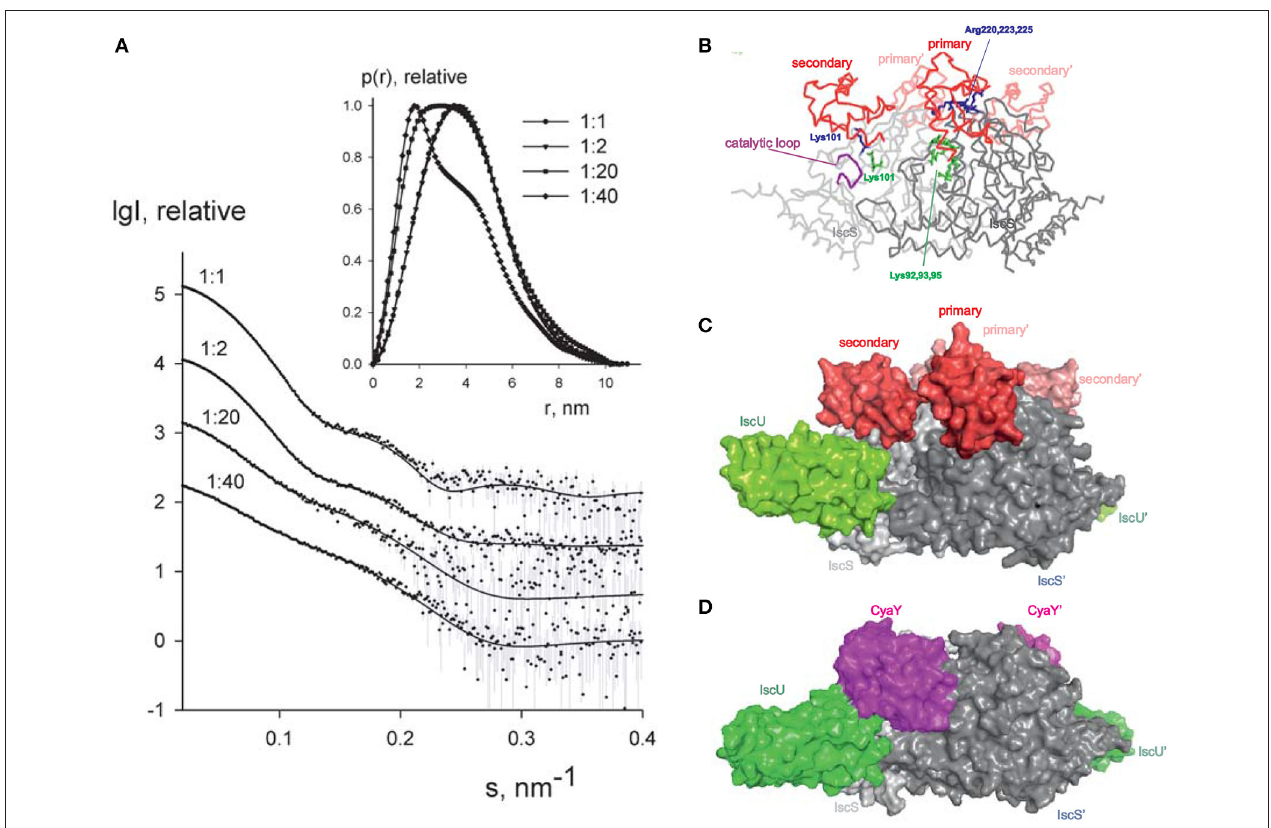
FIGURE 5 | SAXS measurements. (A) X-ray scattering patterns for IscX-IscS at molar ratios of 1:1 (at 5 mg/ml solute concentration), 2:1 (at 3 mg/ml), 20:1 and 40:1 (both at 0.5 mg/ml). The experimental data are displayed as dots with error bars. The scattering from a mixture of two rigid body models (1:1 and 2:1 IscX-IscS complexes) obtained by SASREFMX (for data with 1:1 molar ratio) and the fits by mixtures of unbound IscX, IscS dimers, and 1:1/2:1 rigid body complexes (for data at 2:1, 20:1, and 40:1 molar ratios) as obtained by OLIGOMER are shown by solid lines. The plots display the logarithm of the scattering intensity as a function of the momentum transfer. The distance distribution functions are indicated in the insert. (B) Backbone representation of the 2:1 IscX-IscS complex. The two IscS protomers are shown in different shades of gray. Residues which are either involved in cross-linking or have an effect on binding are indicated. The catalytic loop of IscS is indicated in purple. (C) Same as in (B) in a full atom representation. For reference, IscU (in green) is included (3LVL) to clarify the relative positions of the components. (D) Comparison with the model previously obtained for the ternary complex CyaY-IscS-IscU (Shi et al., 2010). Light and dark gray represent each of the protomers of the IscS